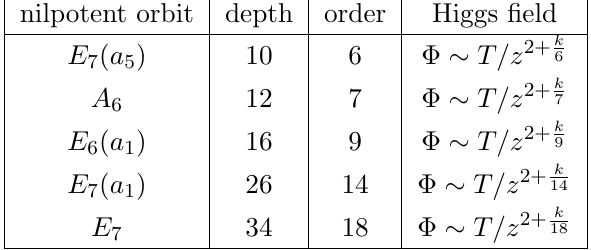
Table 12 . Summary of nilpotent elements of regular semi-simple type in E 7 .